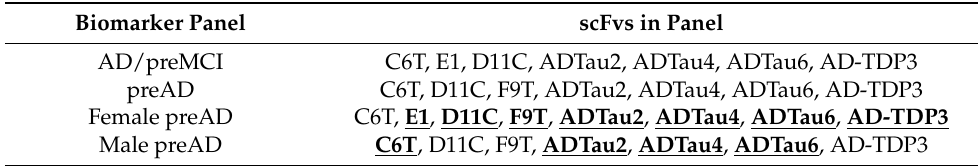
Figure 3. Comparison of plasma samples from preMCI cases with 19 unflagged control cases. Levels of nine different protein variants measured by capture ELISA in preMCI samples from AD cases and unflagged control samples. Significant differences were obtained with seven of the nine scFvs: Aβ (C6T, E1), TDP-43 (AD-TDP3), and tau (D11C, ADTau2, ADTau4, and ADTau6). Data represent mean average score and standard deviation with statistical significance by ANOVA post hoc LSD * p < 0.05. CC denotes clean controls as unflagged control cases. Table 3. Composition of biomarker panels.